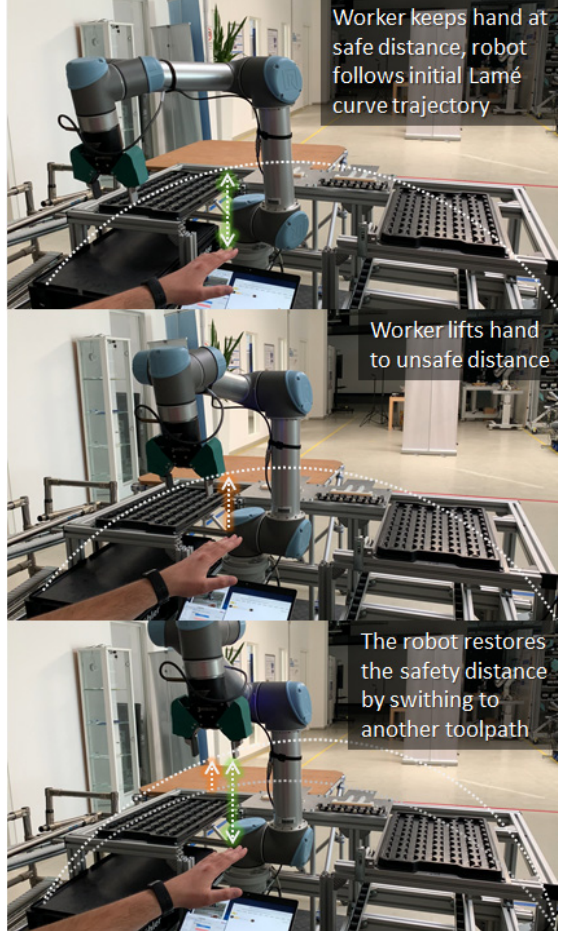
Figure 18. Robot avoids collision by adapting the toolpath to the position of the moving hand.